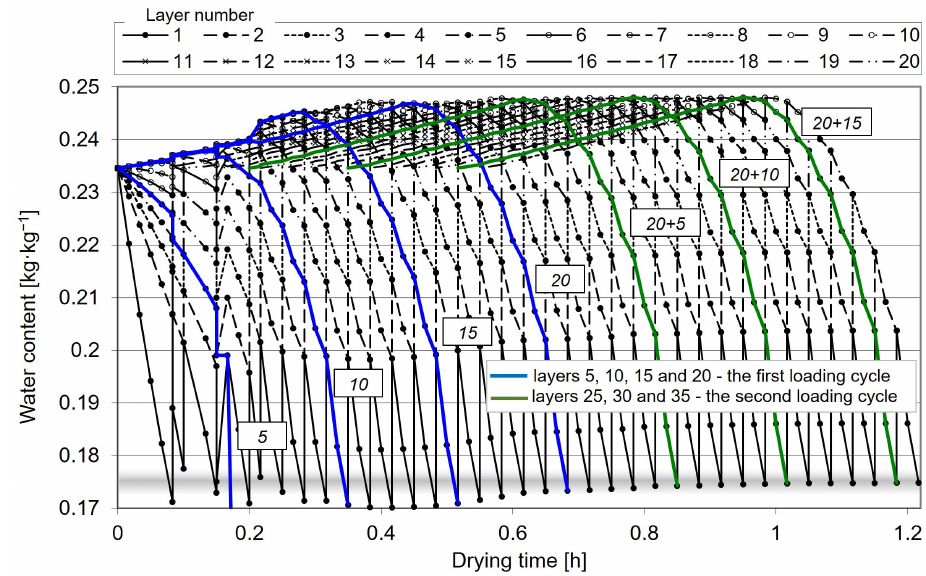
Figure 10. Simulated changes in the moisture content of successive grain layers dried in the counter- flow mode.